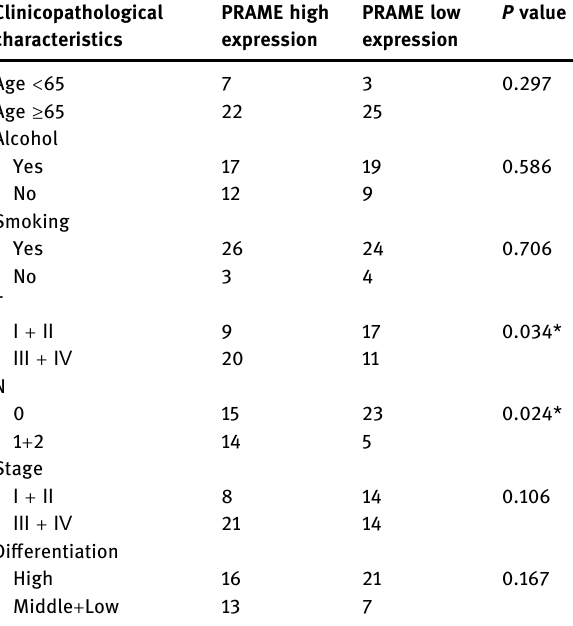
Table 1: Basic clinical information statistics of 57 patients of LSCC Clinicopathological characteristics